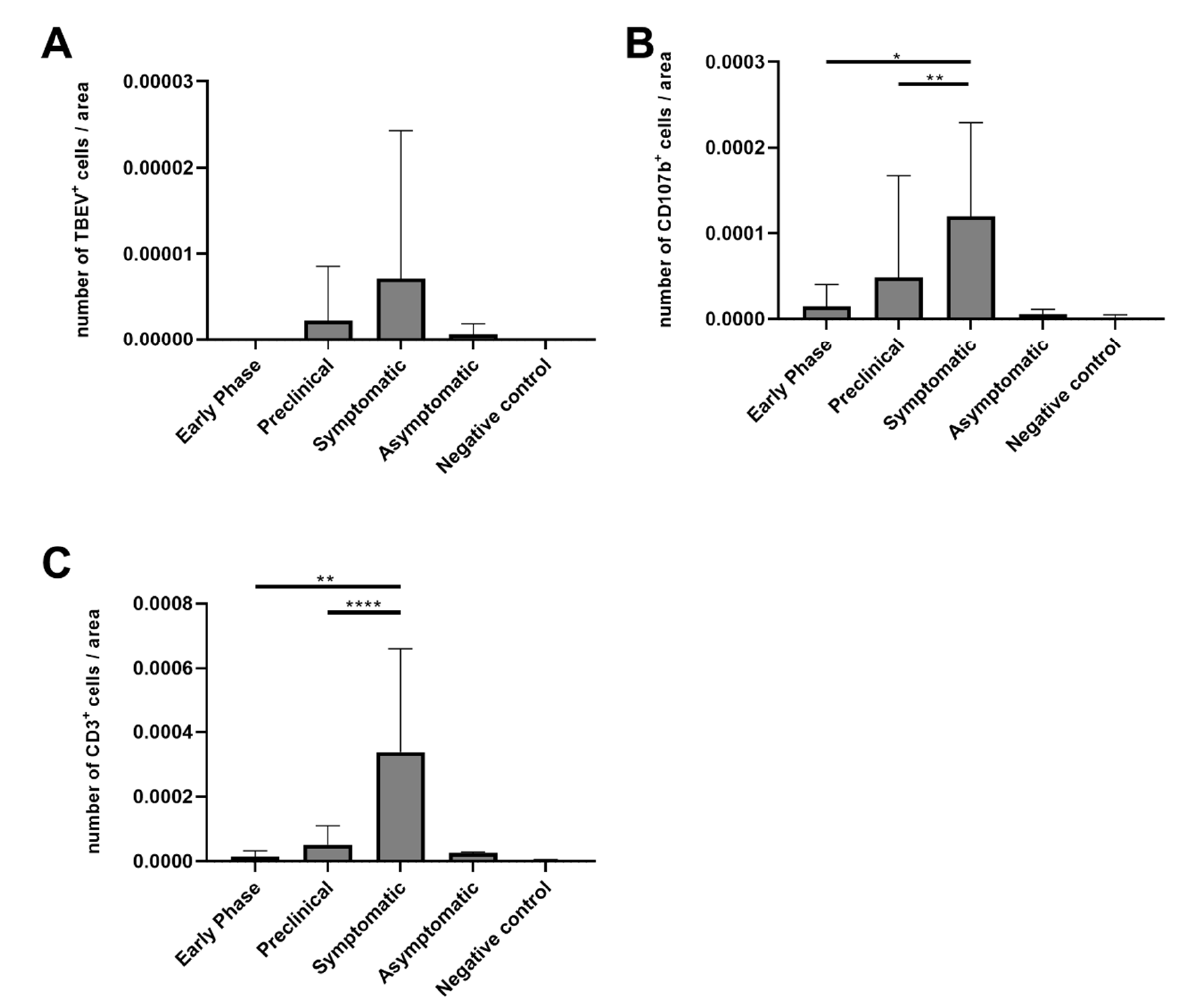
Figure 3. Relative number of specific cell types over the course of infection compared to the total area of the muscularis (m 2 ). ( A ) TBEV + cells, ( B ) CD107b + cells, ( C ) CD3 + cells. Significant differences between each of the three groups (early phase, preclinical and symptomatic) detected by Mann–Whitney-U-test with Bonferroni corrected p values using GraphPad Prism software are indicated by asterisks (* p 0.033, ** p 0.0033 and **** p